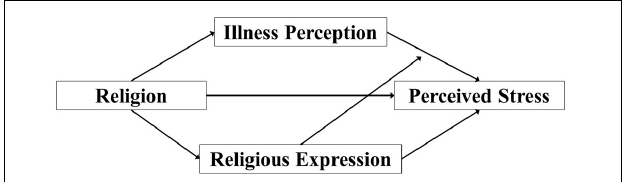
FIGURE 1 | Theoretical framework of the relationship between religion, illness perception, religious expression, and perceived